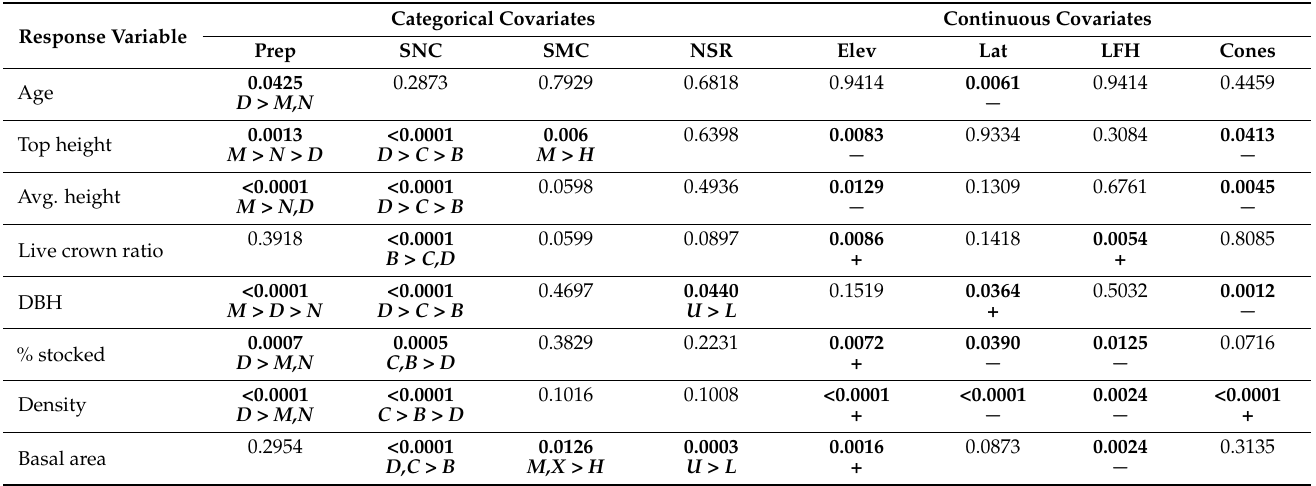
Table 4. Significance ( Prob > F values) and trends of responses to covariates.